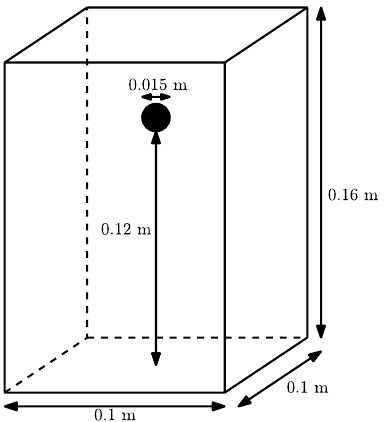
Figure 1. Setup of the simulation according to ten Cate at al. [49].